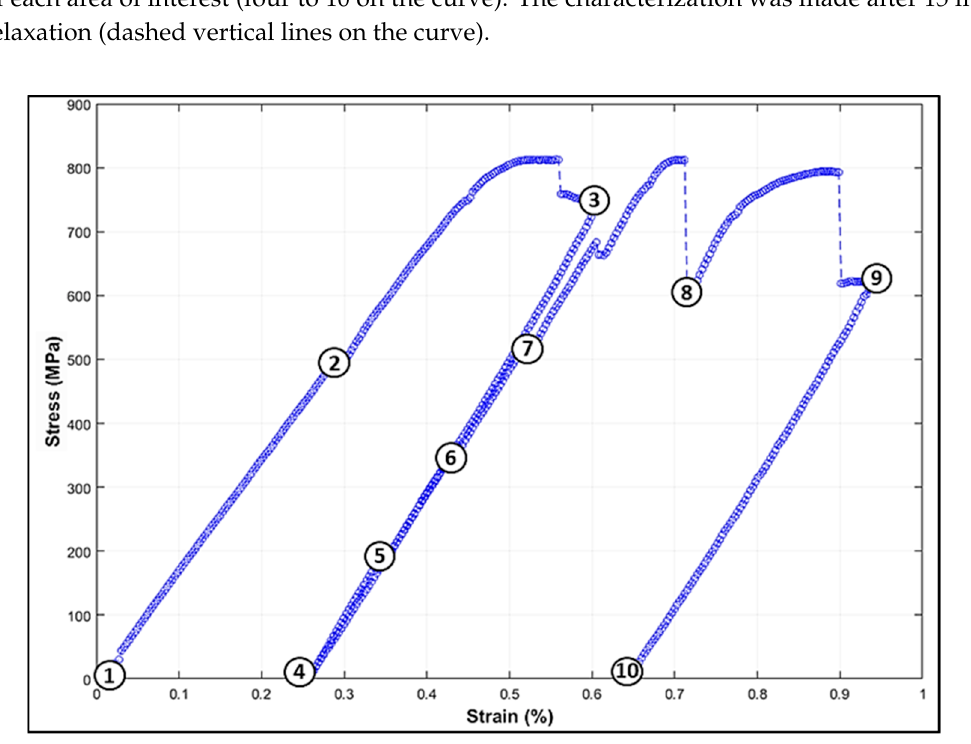
Figure 3. In situ obtained stress-strain curve of the β -Ti21S showing the positions where observations/Accurate Electron Channeling Contrast Imaging (A-ECCI) were made: before loading (1), during elastic deformation (2: no defect formation was observed), at the beginning of the plastic domain (3), and for six intermediate states of the second tensile cycle before unloading (four to 10). The dashed vertical lines correspond to the relaxation after plastic deformation.